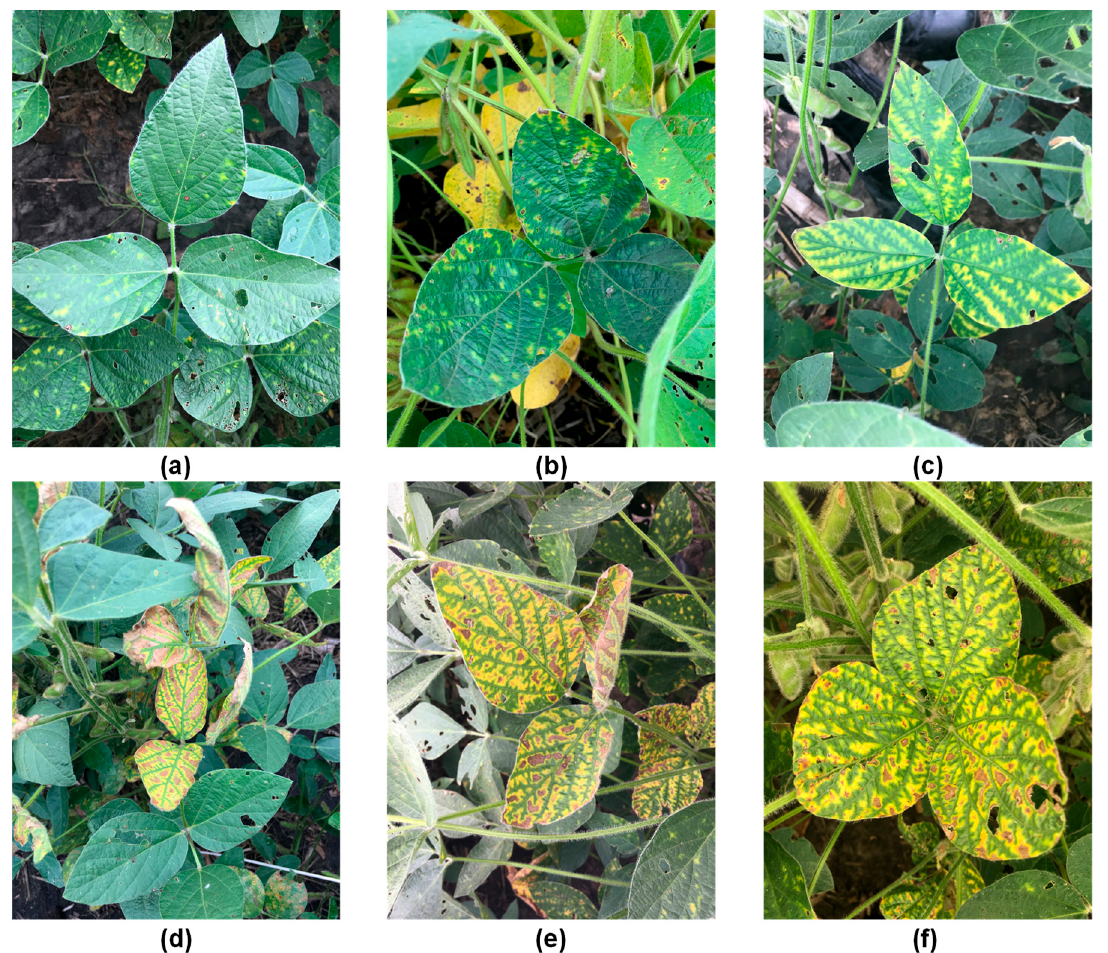
Figure 3. Foliar symptoms of soybean sudden death syndrome. Foliar symptom development starts as scattered yellow spots ( a , b ) which later enlarge ( c ) and turn into large regions of interveinal chlorosis and necrosis on leaves ( d – f ). Table 1. Description of spectral bands of PlanetScope satellite ortho scenes used in this study. PlanetScope